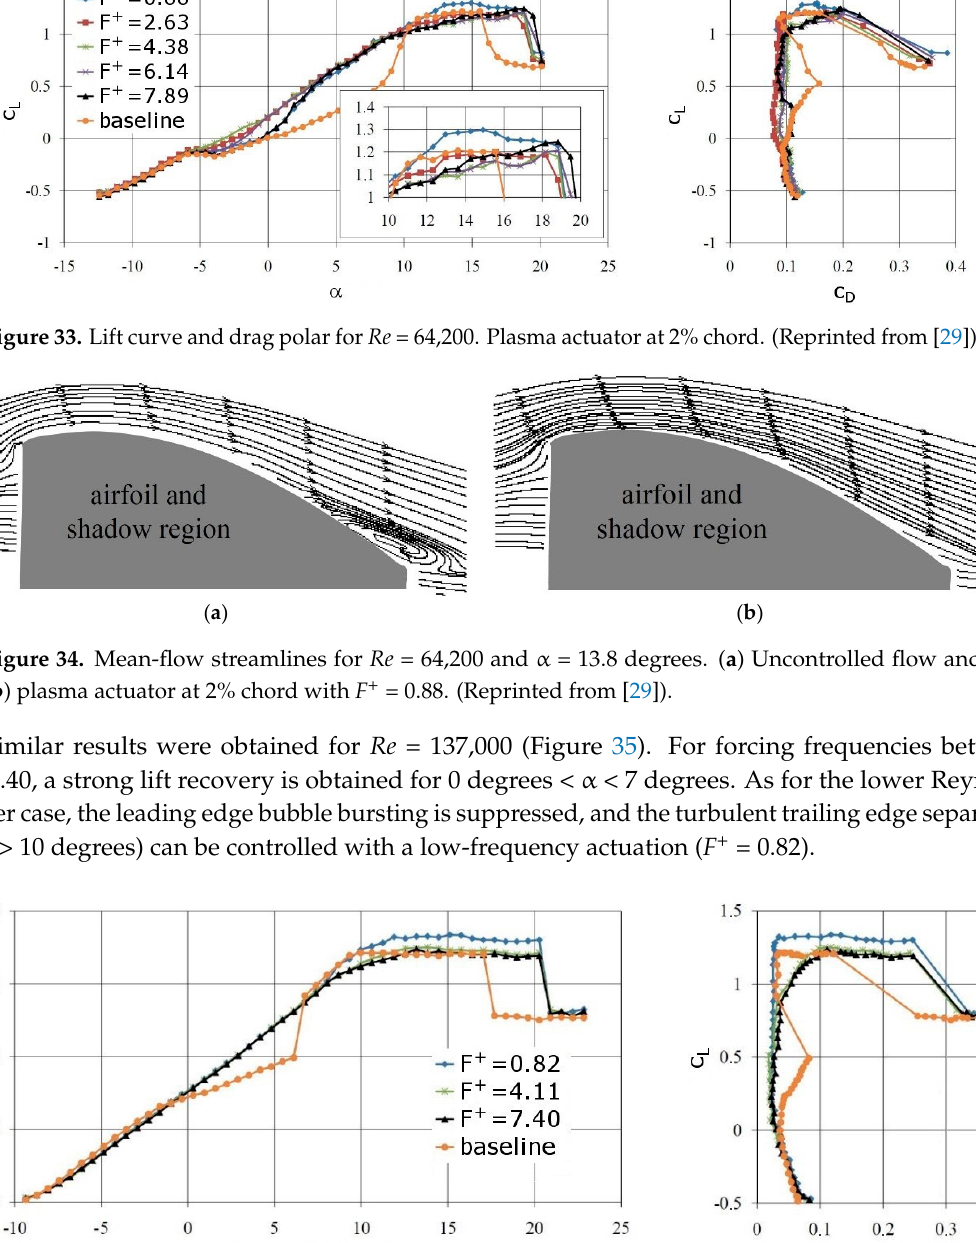
Figure 35. Lift curve and drag polar for Re = 137,000. Plasma actuator at 2% chord. (Reprinted from [29]).